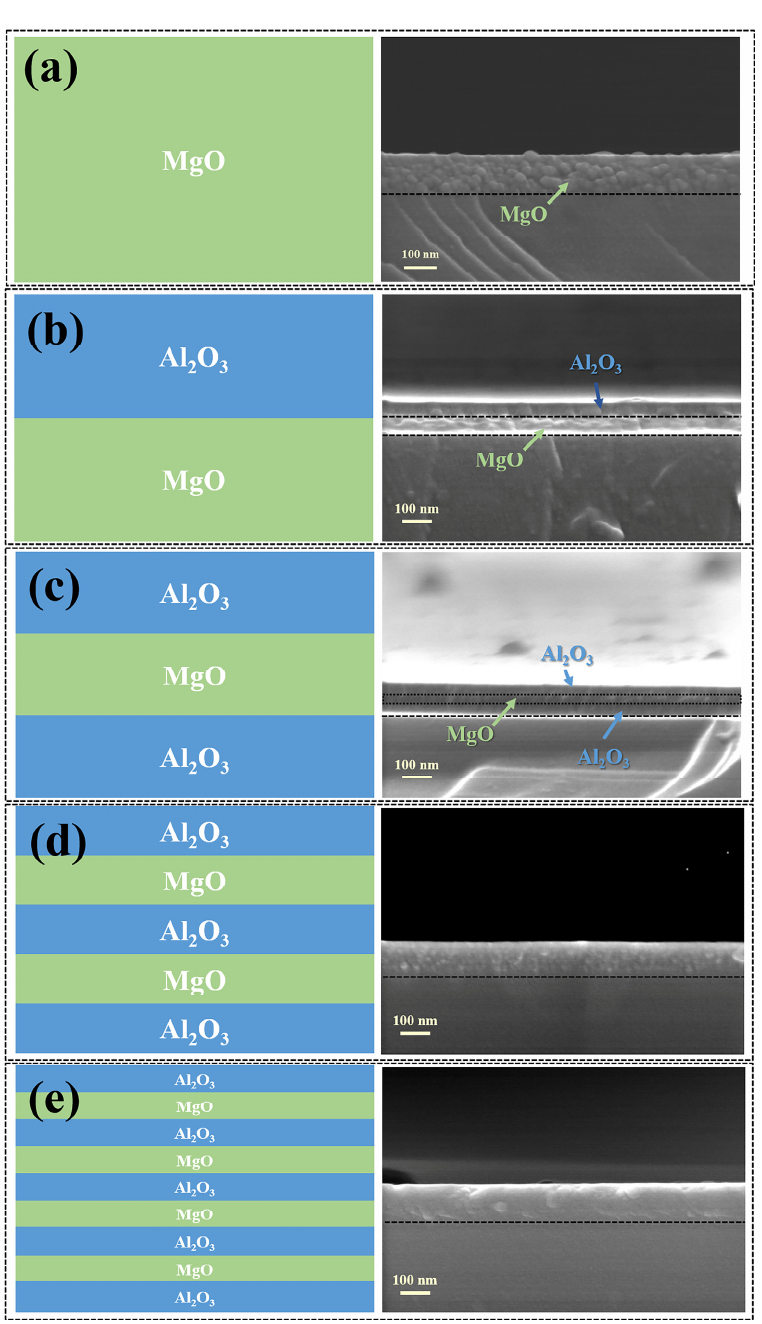
Figure 5. Structure diagram and cross-section SEM morphology of 100 nm thin film: ( a ) MgO, ( b ) 1:1 Al 2 O 3 :MgO layer alternation type, ( c ) 2:1 Al 2 O 3 :MgO layer alternation type, ( d ) 3:2 Al 2 O 3 :MgO layer alternation type, and ( e ) 5:4 Al 2 O 3 :MgO layer alternation type.